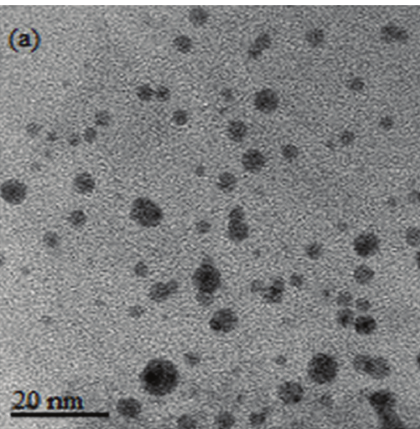
Figure 4: TEM image of chitosan-Ag nanoparticle materials syn- thesized with 0.02 M AgNO 3 .